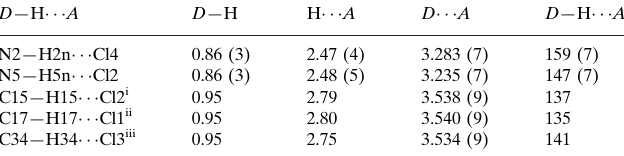
Hydrogen-bond geometry (A˚ , (cid:3)